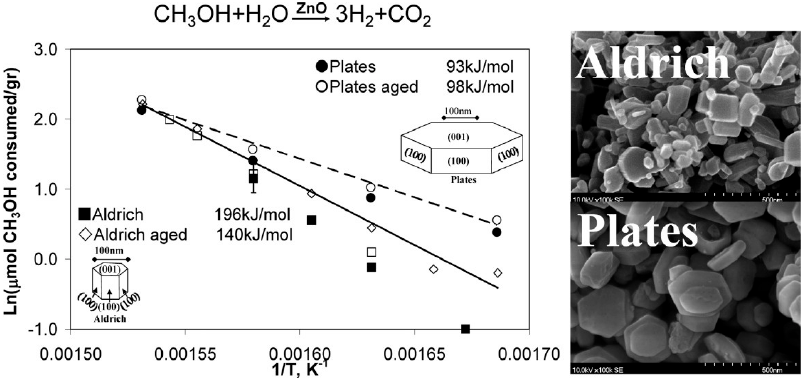
Figure 1. Arrhenius plot for ZnO samples: ( ● ) plates; ( ○ ) plates aged; ( ■ ) Aldrich; ( □ ) Aldrich repeated; ( ◇ ) Aldrich aged. Reproduced with permission from [117]. Copyright American Chemical Society, 2013.